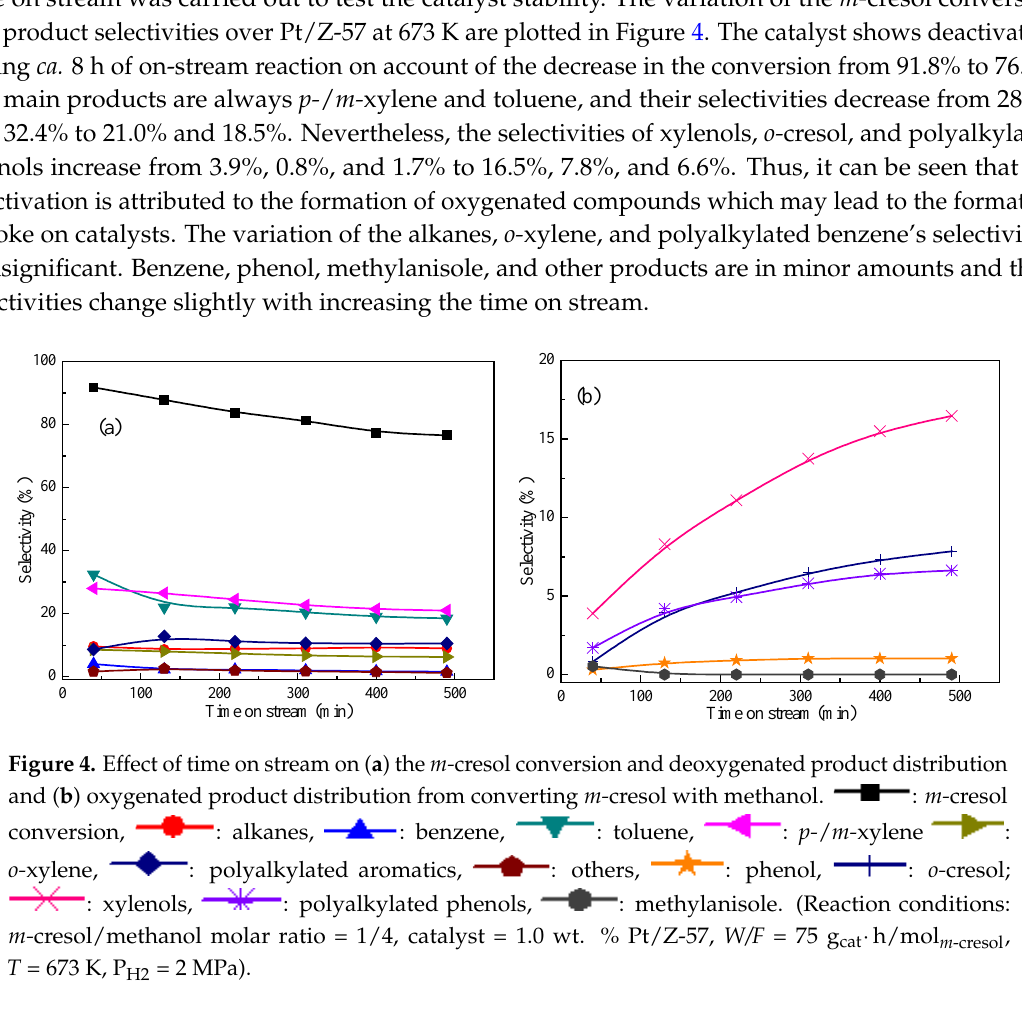
Figure 5. TGA profiles of the spent 1.0 wt. % Pt/Z-57 catalysts.